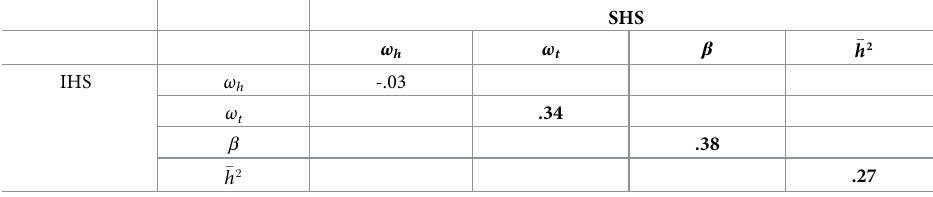
Table 8. Correlation between happiness measure reliabilities across